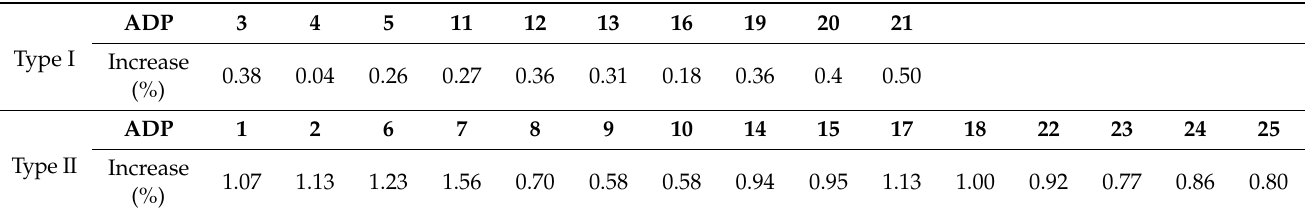
Table 3. The classification of two types of RBP test biogas-production time series according to the absolute average of the daily biogas production change percentages in the last four days.